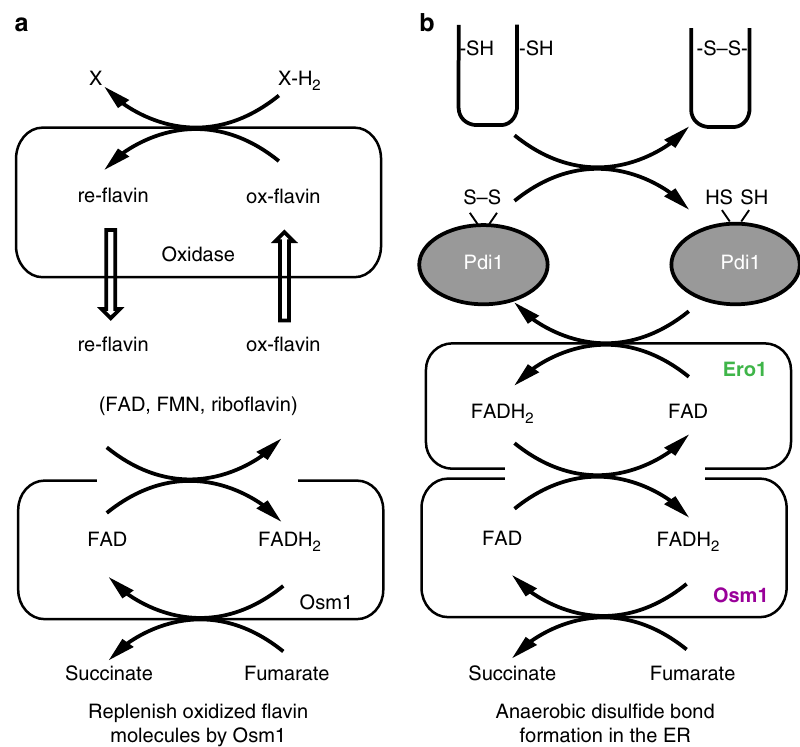
Fig. 6 Model of the function of Osm1. Our proposed models showed that Osm1 functions as a master regulator of the redox state of fl avin molecules ( a ) and disul fi de bond formation in the ER under anaerobic conditions ( b